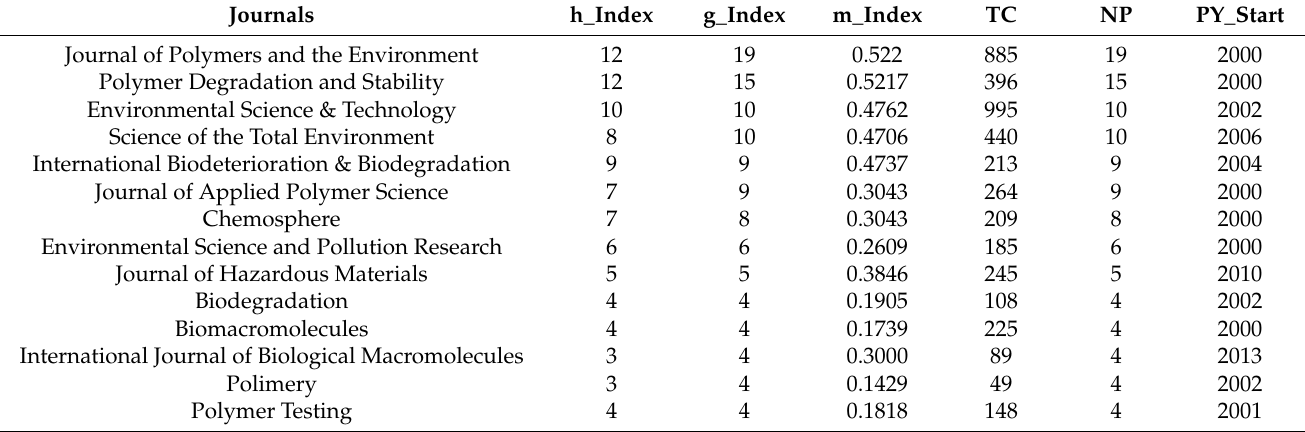
Table 4. Relevant journals in biodegradation-of-plastics-related research between 2000 and